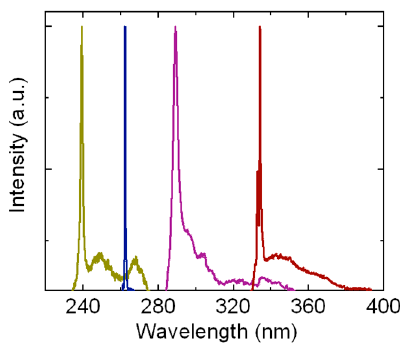
Figure 13. Lasing by direct electrical injection measured from AlGaN nanowire structures with different alloy compositions and cavity designs [50,92–94].